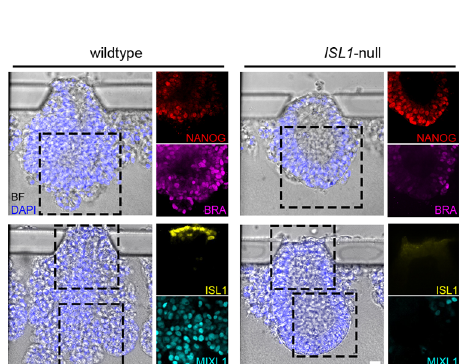
Fig. 6 Embryonic-like sac assay. See also Supplementary Fig. 13. Bright fi eld (BF) images of embryonic-like sacs overlayed with nuclei stained with DAPI (blue) derived from wild-type (left side) and ISL1 -null (right side) hESCs. Immuno fl uorescent staining for NANOG (red), BRA (magenta), ISL1 (yellow), and MIXL1 (cyan) are shown in the panels on the right-hand side of the corresponding bright fi eld images. n > 15 for each. Scale bar, 20 µ